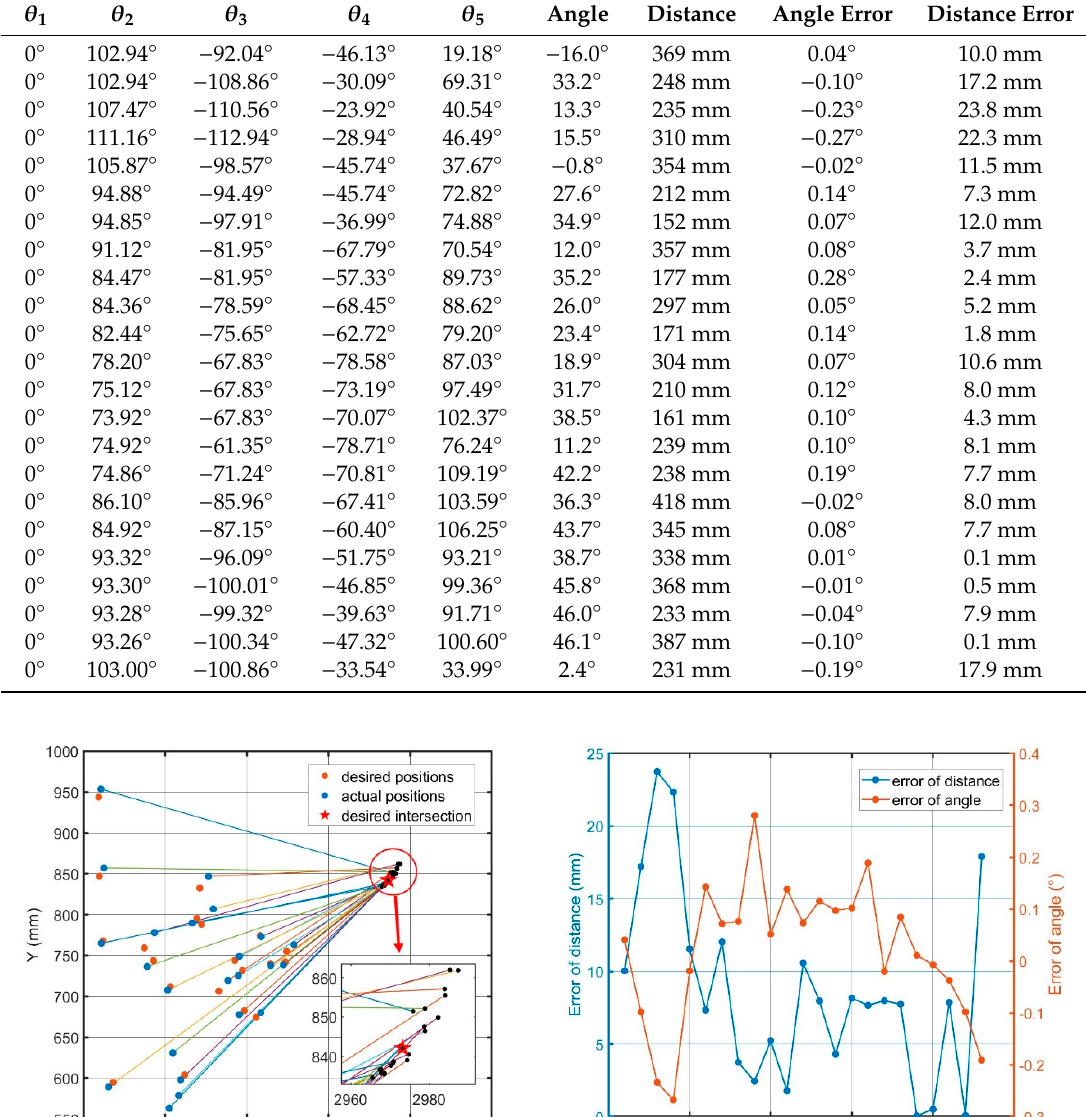
Table 1. The e W measurement data.